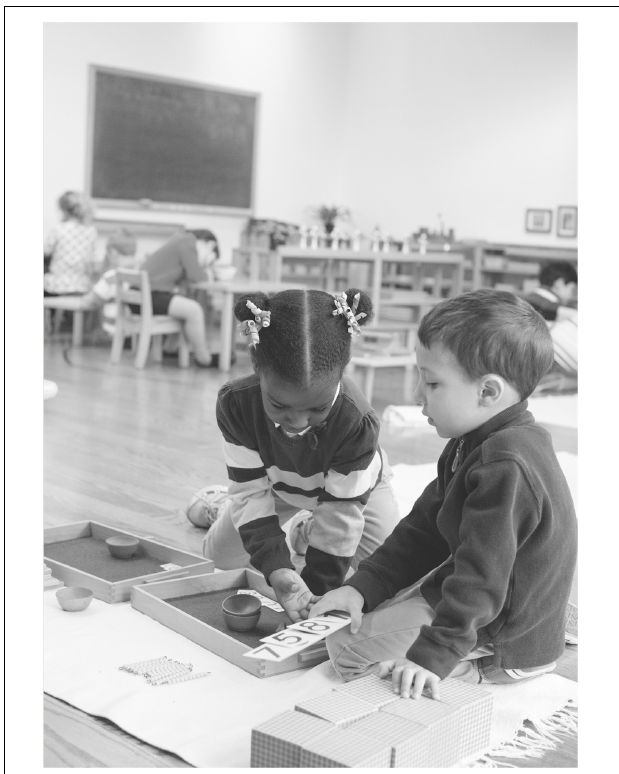
FIGURE 6 | Two children working with Montessori decimal materials, with which preschool children perform multiplication and division of 4-digit numbers. Photograph by Laura Joyce-Hubbard, provided by courtesy of Forest Bluff